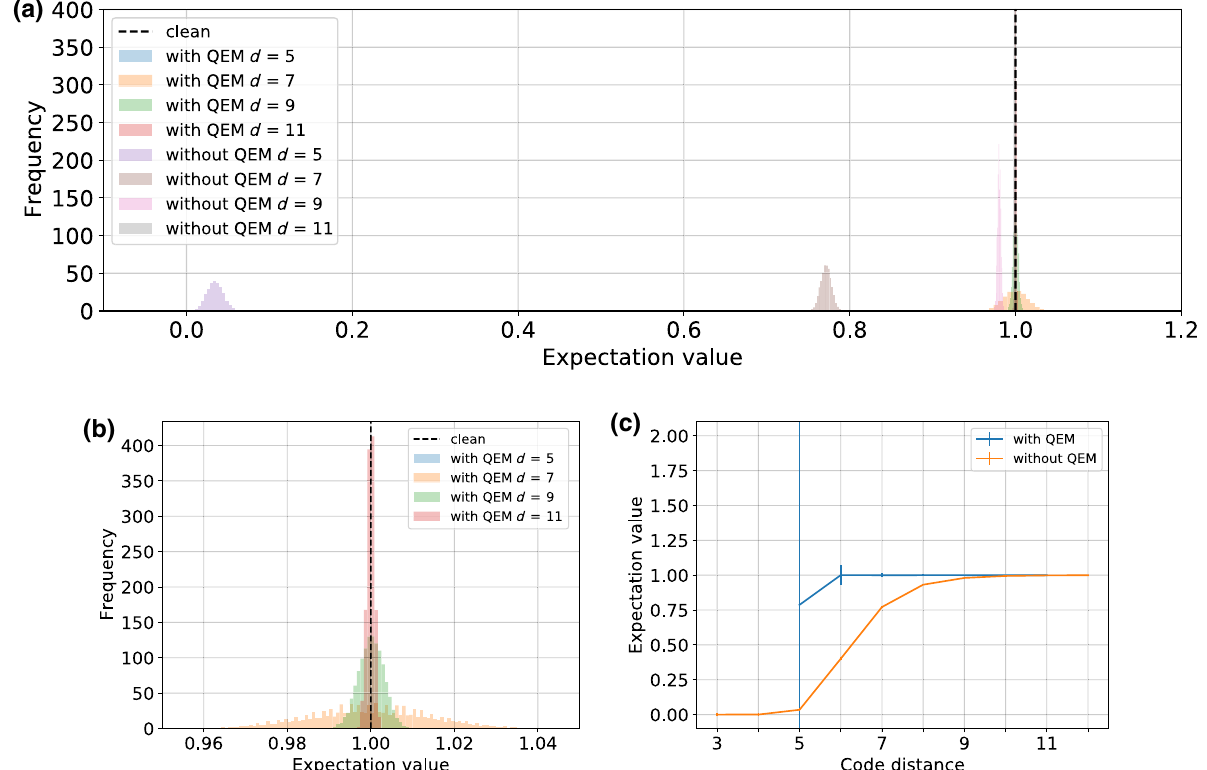
FIG. 5. (a) Histogram of expectation values for 100-qubit random Clifford circuits. (b) Histogram of expectation values with QEM for 100-qubit random Clifford circuits. (c) Sample averages and standard deviation of 100-qubit random Clifford circuits are plotted as a function of code